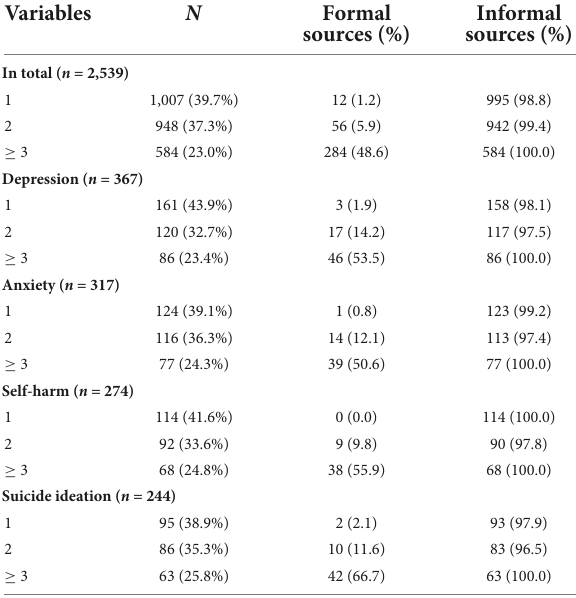
TABLE 4 Number of help-seeking